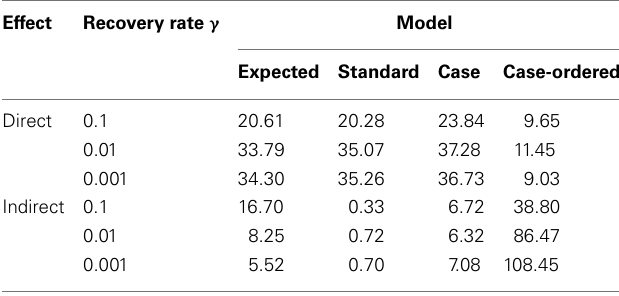
Table 1 | Genetic variance